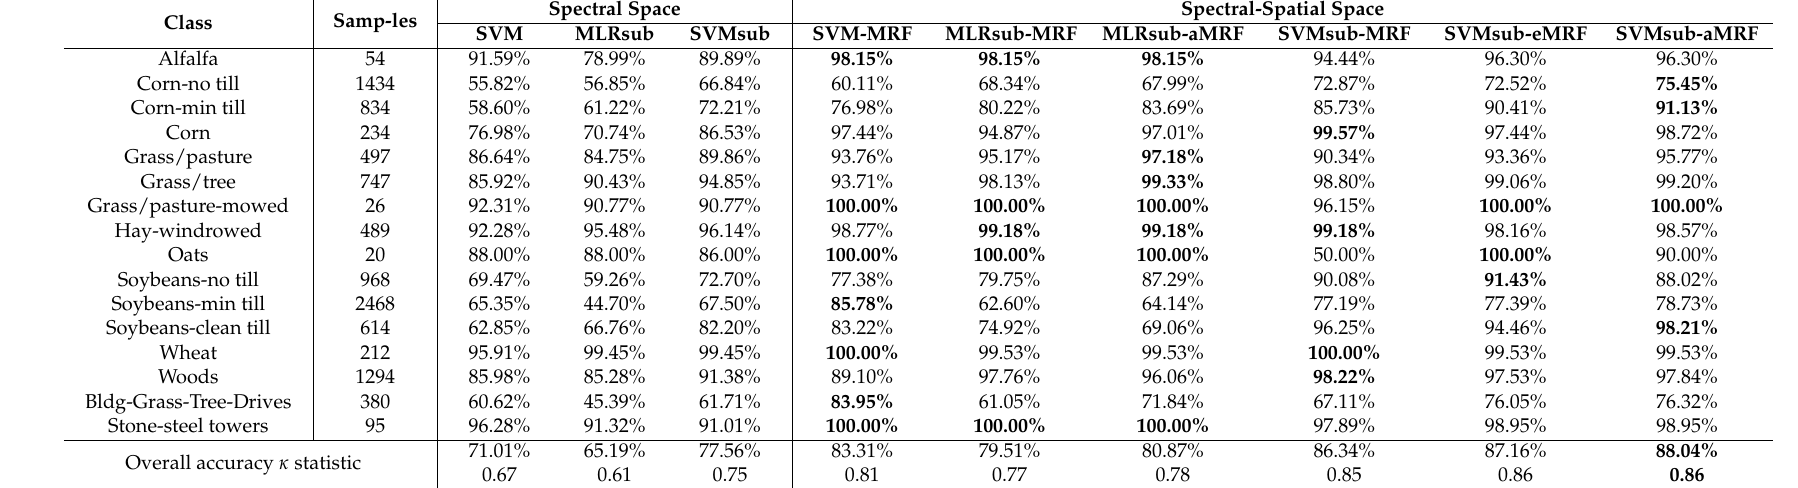
Table 2. Overall and average class accuracies and κ statistic values obtained for the AVIRIS Indian Pines data set using 200 spectral bands and a training sample size of 30 samples per class. The best results are highlighted in bold